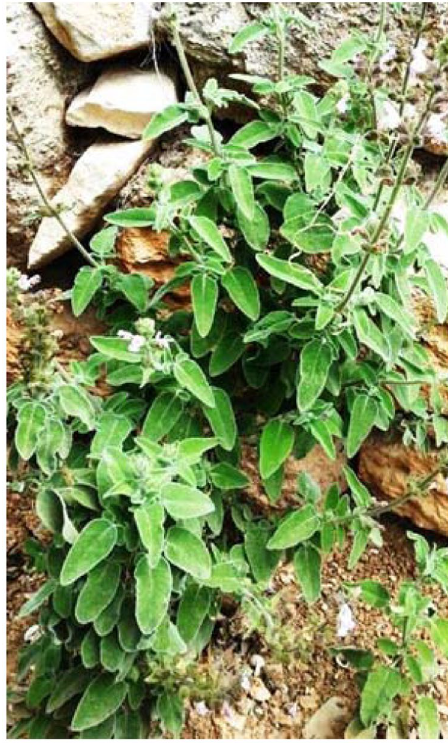
Figure 1. Salvia fruticosa Mill. (Sage). A photograph showing the aerial parts of SF. For medicinal uses, leaves are the most commonly consumed part of this